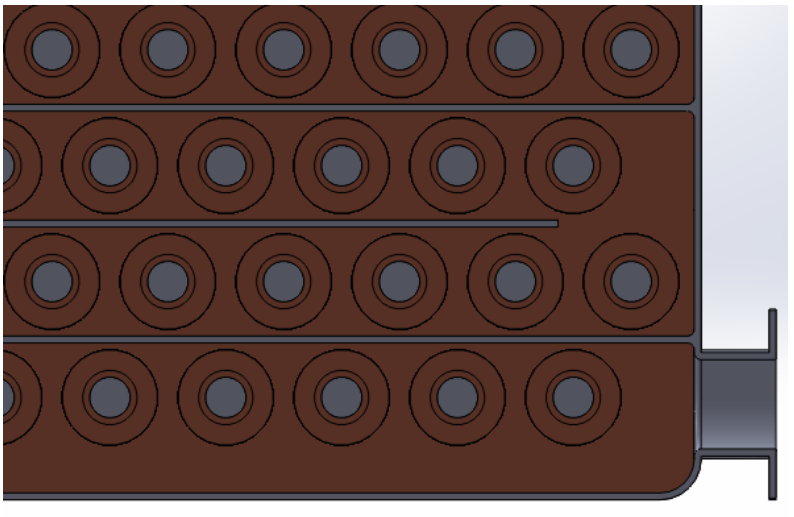
Figure 10. Section view of the inlet cooling water zone, side